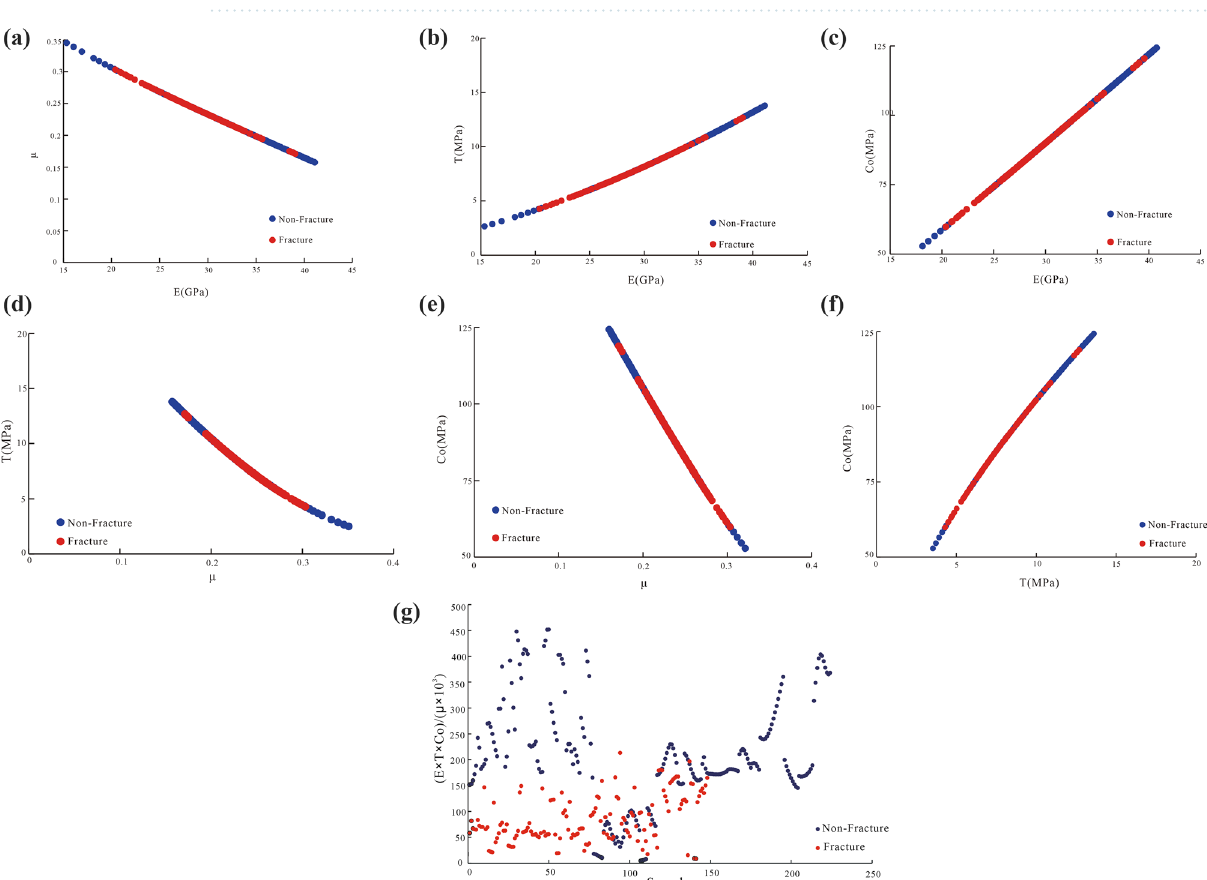
Figure 9. Physical response characteristics of fractured and non-fractured rock, including Young’s modulus (E), tensile strength (T), compressive strength (C o ), and Poisson’s ratio